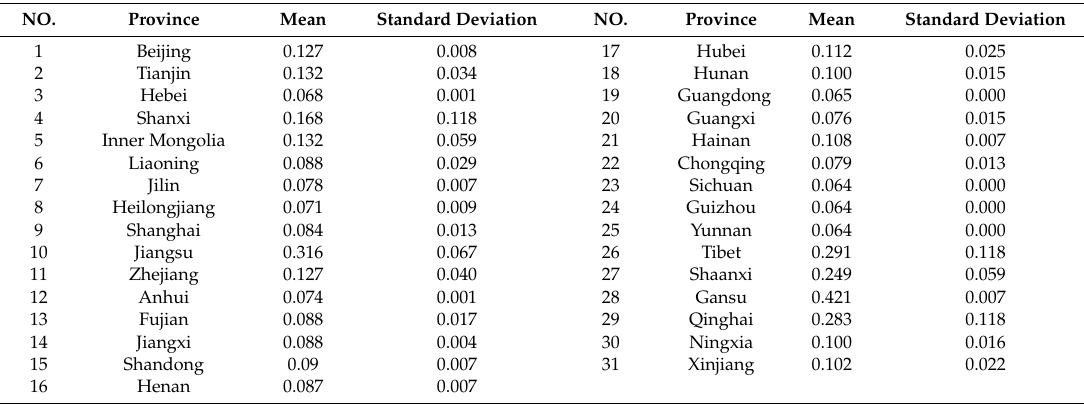
Table 6. The impact of financial development on agricultural NPS pollution in China. NO. Province Mean Standard Deviation NO. Province Mean Standard